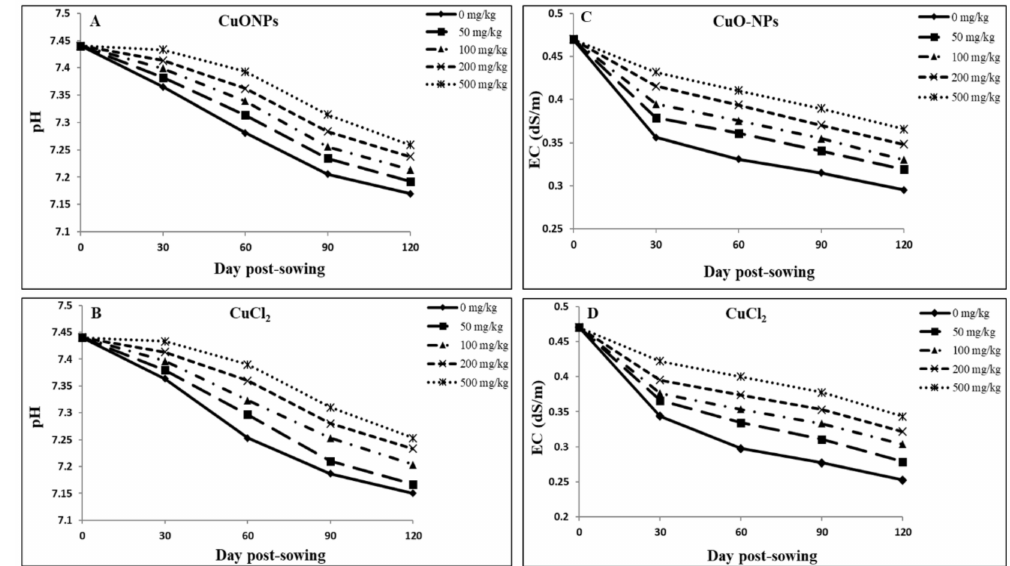
Figure 5. Changes in soil pH ( A , B ) and electrical conductivity (EC) ( C , D ) of soil amended with CuONPs ( A , C ) and CuCl 2 ( B , D ) during the full growth period of 120 days in soybean. The data are averaged for all three types of CuONPs as they were similar among the NP